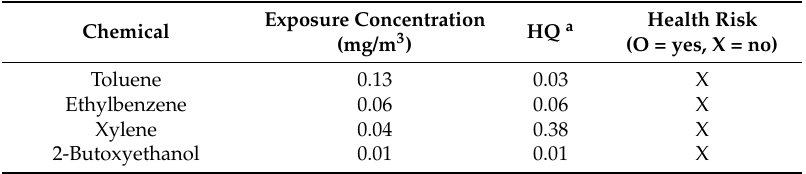
Table 7. Tier 2 assessment